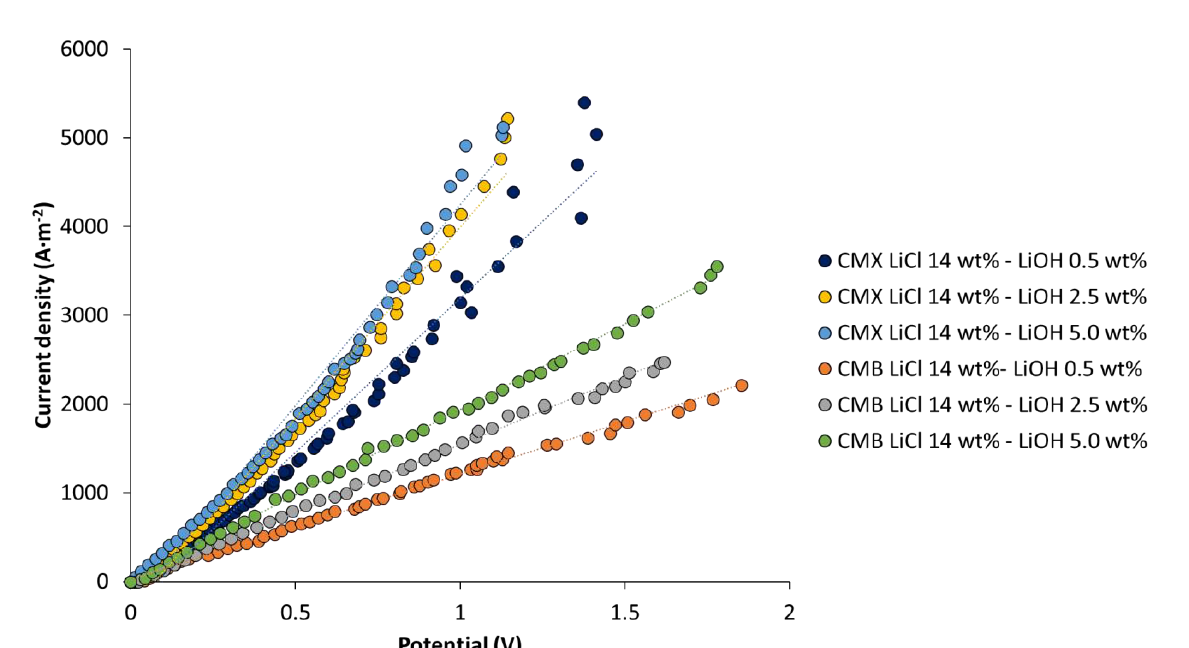
Figure 9. Linear sweep voltammetry in cationic membranes.